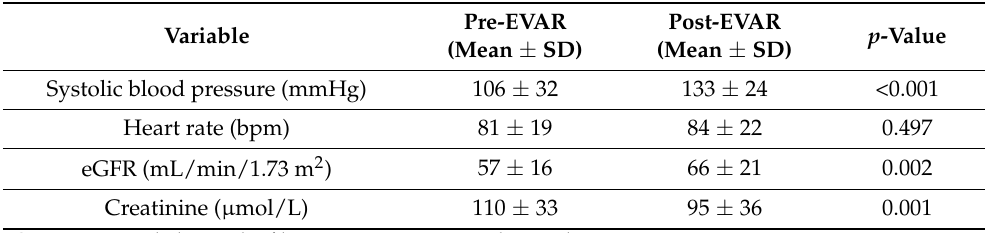
Table 2. Hemodynamic and renal parameters upon presentation at emergency department and